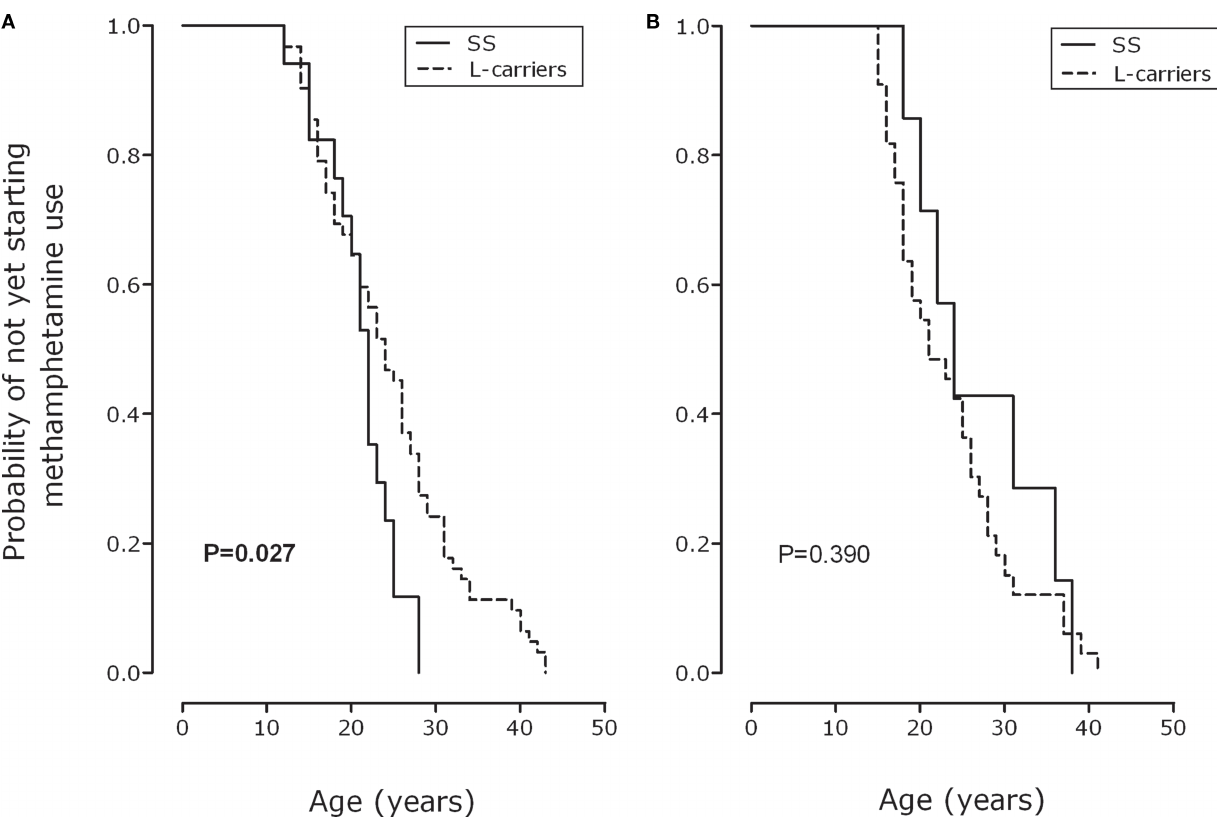
FiGuRe 1 | Probability of not yet starting methamphetamine use as a function of age for SS and L-carriers of the serotonin transporter-linked polymorphic region in males (A) and females